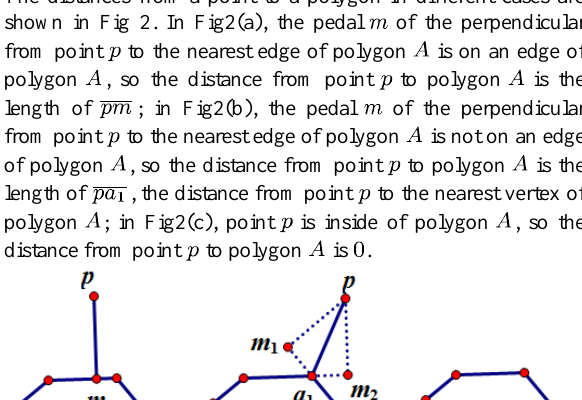
Fig3. Boundary points and vertices of a polygon: (a) The boundary points of a polygon; (b) The vertices of a